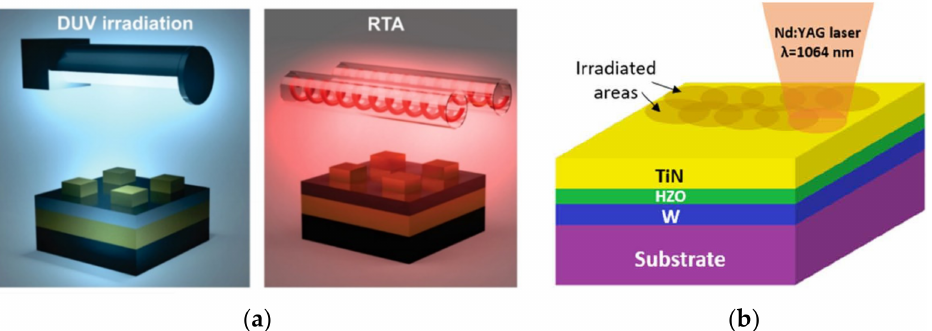
Figure 4. ( a ) Schematic view of low temperature RTA annealing with DUV irradiation. Reproduced with permission [70]. Copyright 2021, American Chemical Society. ( b ) schematic view of laser irradiation on HZO film. Reproduced with permission [67]. Copyright 2021